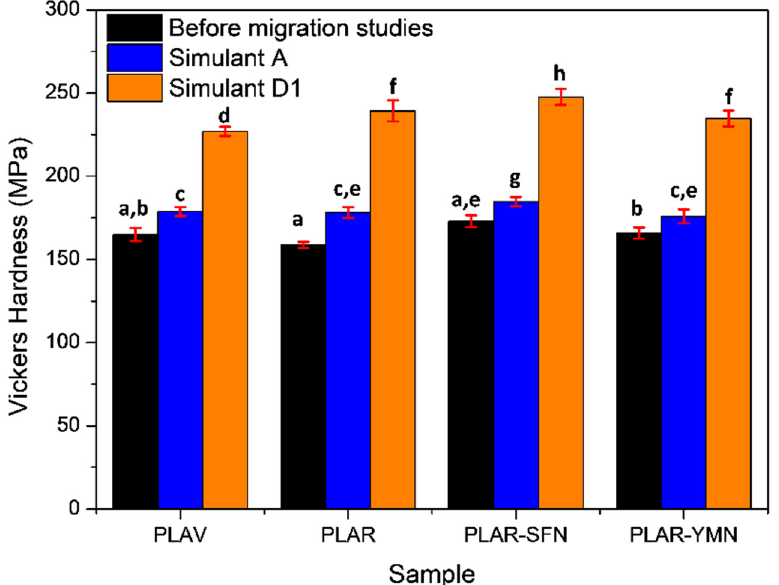
Figure 8. Vickers hardness of the samples before and after immersion in food simulants. a–h Different letters indicate statistically significant differences between formulations ( p < 0.05).